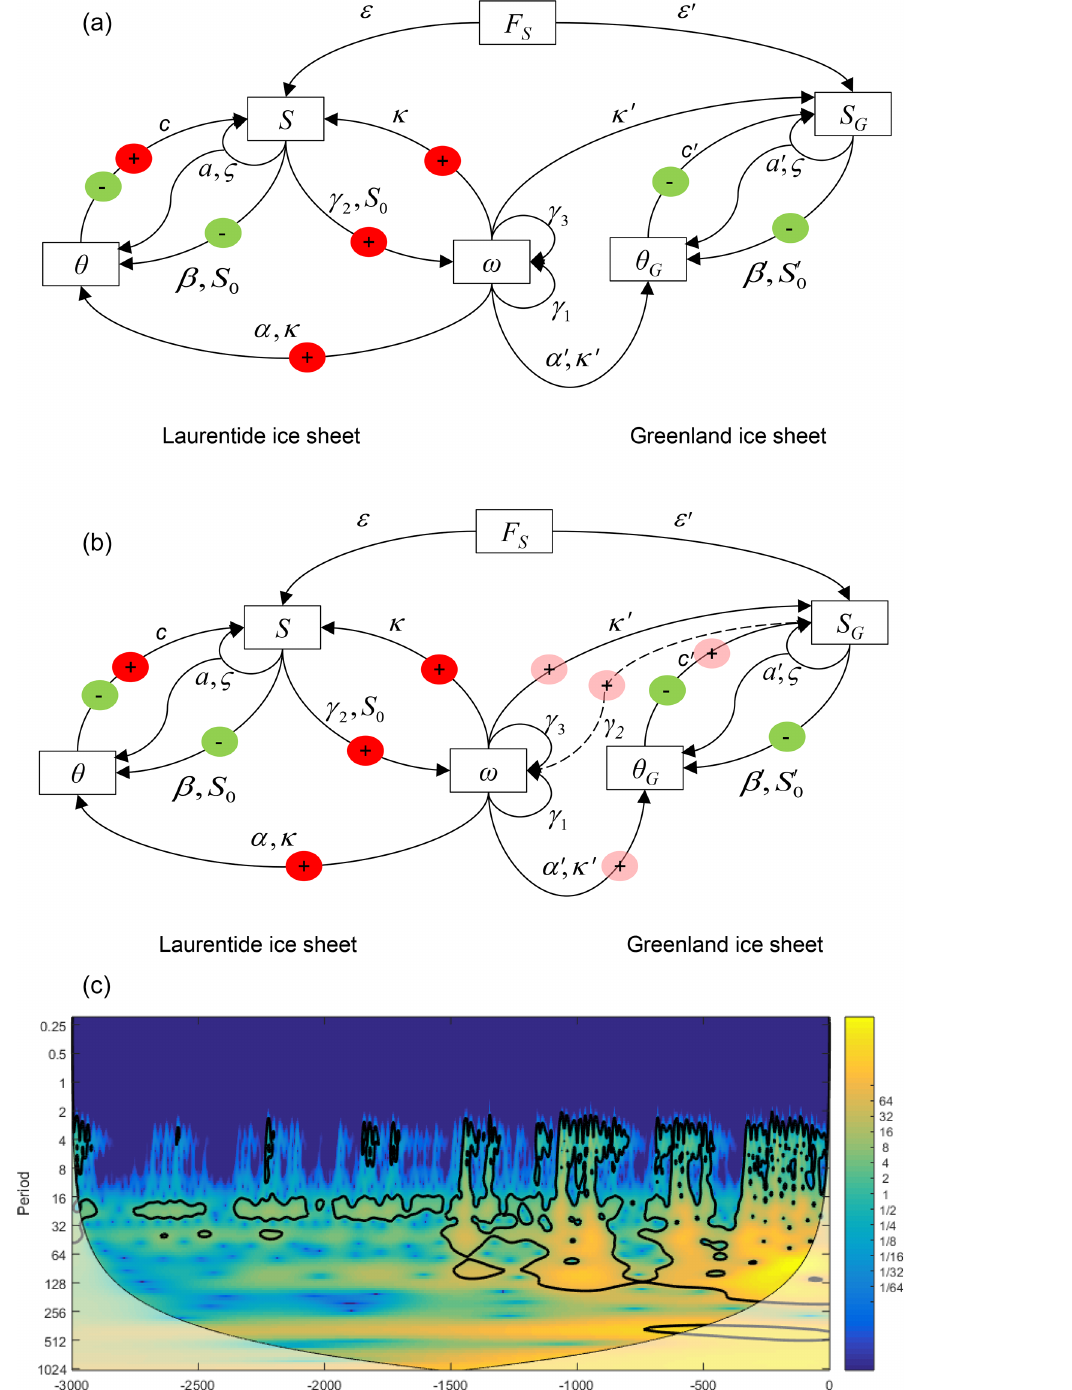
Figure 1. (a) The dynamical system (Eqs. 1–5) as it has been used for scaling reasoning. The Greenland ice sheet is coupled one-way via the climate temperature ω acting as an external forcing for it. Red circles mark positive feedback loops and green circles mark negative feedback loops; (b) the dynamical system (Eqs. 1–5) as it has been used in the numerical simulation. The Laurentide and Greenland ice sheets are fully coupled. Pink circles mark weaker positive feedback loops. (c) Evolution of wavelet spectra over the past 3Myr for the Greenland glaciation area S G (10 6 km 2 ). The color scale shows the continuous Morlet wavelet amplitude, the thick line indicates the peaks with 95% confidence, and the shaded area indicates the cone of influence for wavelet